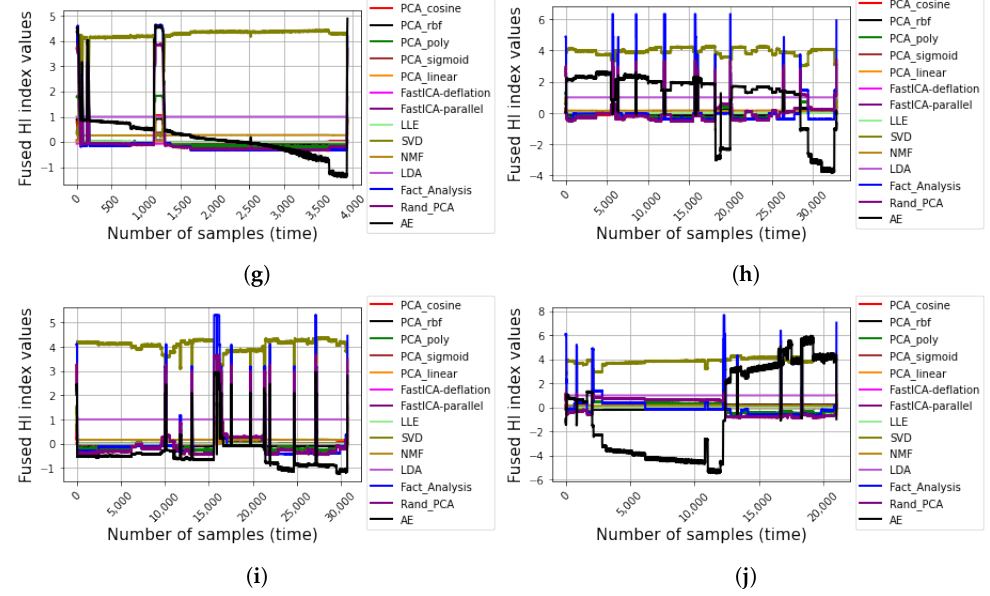
Figure 8. Constructed HIs from the respective fusion algorithms for ( a ) C17-1, ( b ) C17-2, ( c )